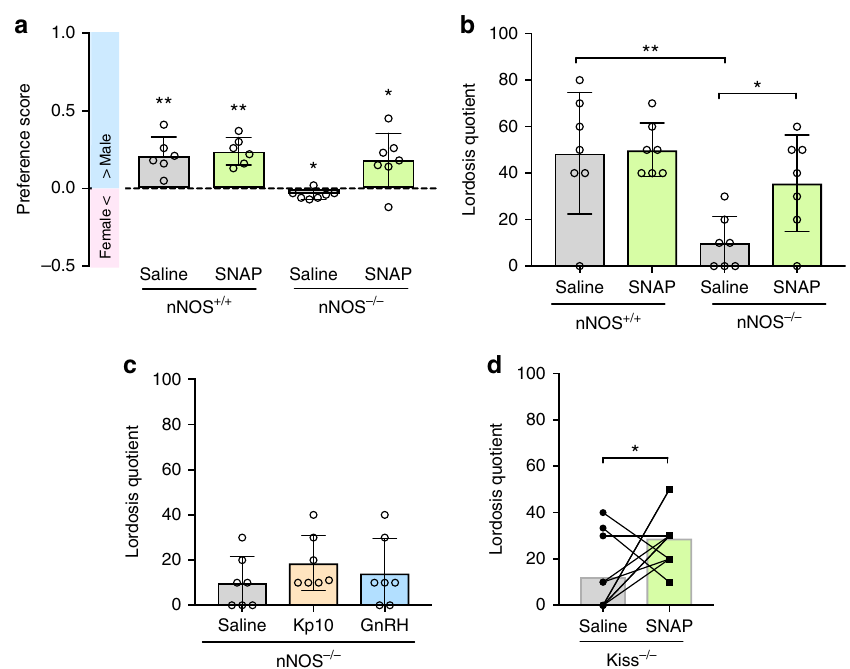
Fig. 6 Mate preference and lordosis behavior depend on nitric oxide signaling. a nNOS knockout ( nNOS − / − ) female mice do not show a male-directed preference, whereas female control littermates displayed a preference for the male. Strikingly, a single peripheral injection with SNAP+BAY 41-2272, NO donor and soluble guanylate cyclase agonist induced a signi fi cant preference for the male in nNOS − / − female mice. * P ≤ 0.05; ** P ≤ 0.01; one-sample t test (H0: mean equals 0); n = 6 ( nNOS + / + ) and 7 ( nNOS − / − ). b Lordosis behavior is disrupted in nNOS knockout ( nNOS − / − ) mice, but restored by a peripheral injection of the NO donor SNAP (together with BAY 41-2272); * P ≤ 0.05; ** P ≤ 0.01; Tukey ’ s multiple comparison test; n = 7 per group. c By contrast, a peripheral injection of either kisspeptin or GnRH failed to restore lordosis behavior in nNOS − / − mice; ANOVA; n = 7 per group. d A peripheral injection